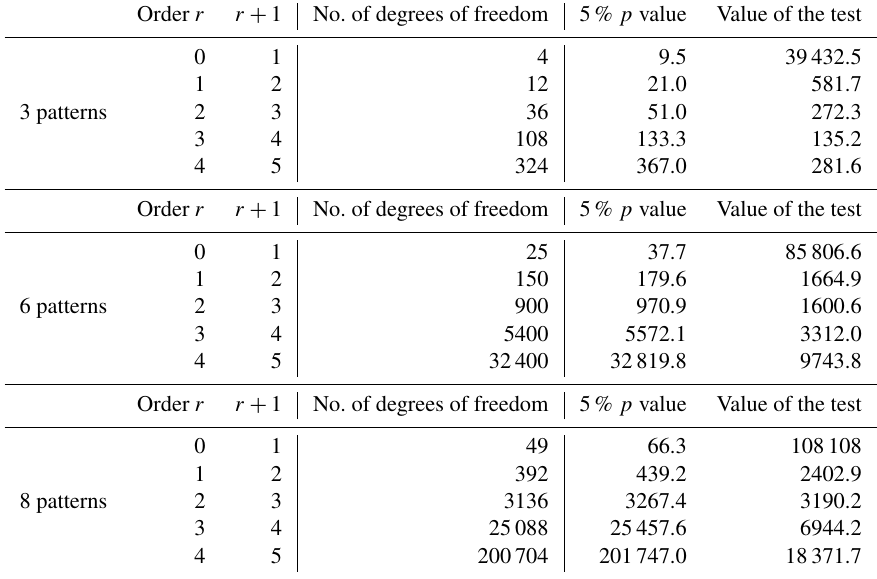
Table A1. Test χ 2 for three, six and eight weather patterns for the series of observations. The first two columns represent the two Markov orders that are compared. The third column contains the number of degrees of freedom of the test. The fifth and sixth columns contain the p value of the test at the 5% level and the actual value of the test. If the actual value is smaller than the p value, the order r is considered the order of the Markov chain necessary to describe the dynamics of the weather